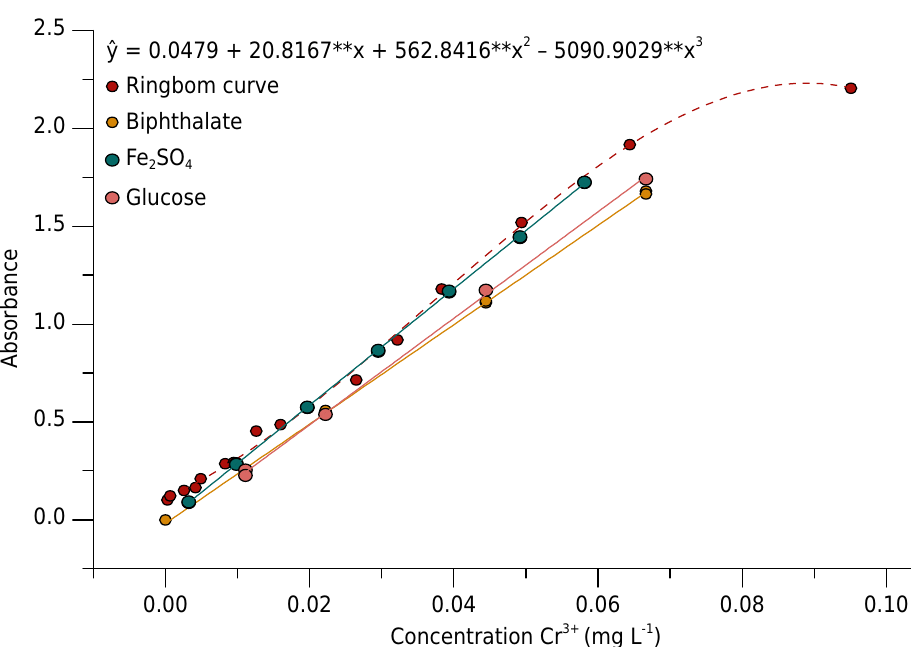
Figure 1. Analytical calibration curves obtained by using glucose, potassium biphthalate, and ferrous sulfate, and Ringbom curve obtained by the spectrophotometric method in the visible region, according to the proportions of the reagents of Walkley-Black